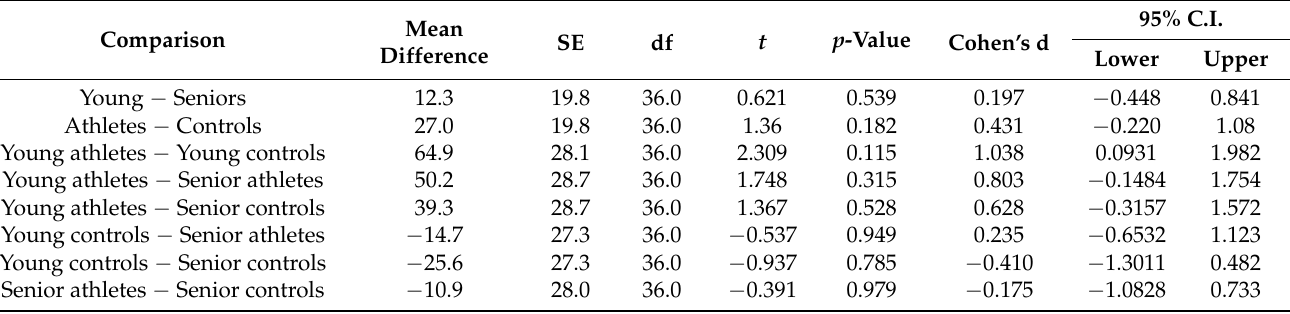
Table 7. ANOVA results for vertical